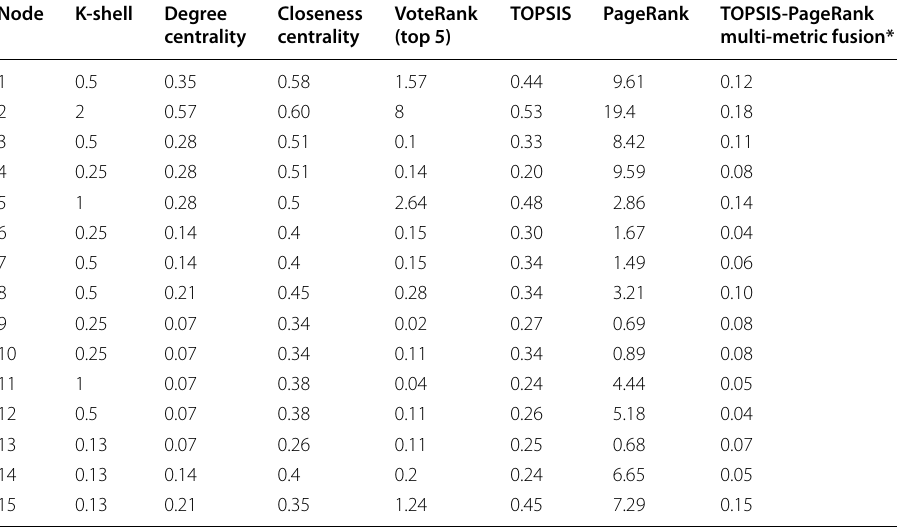
Table 3 Evaluation table of node contribution under different algorithms Node K‑shell Degree Closeness centrality